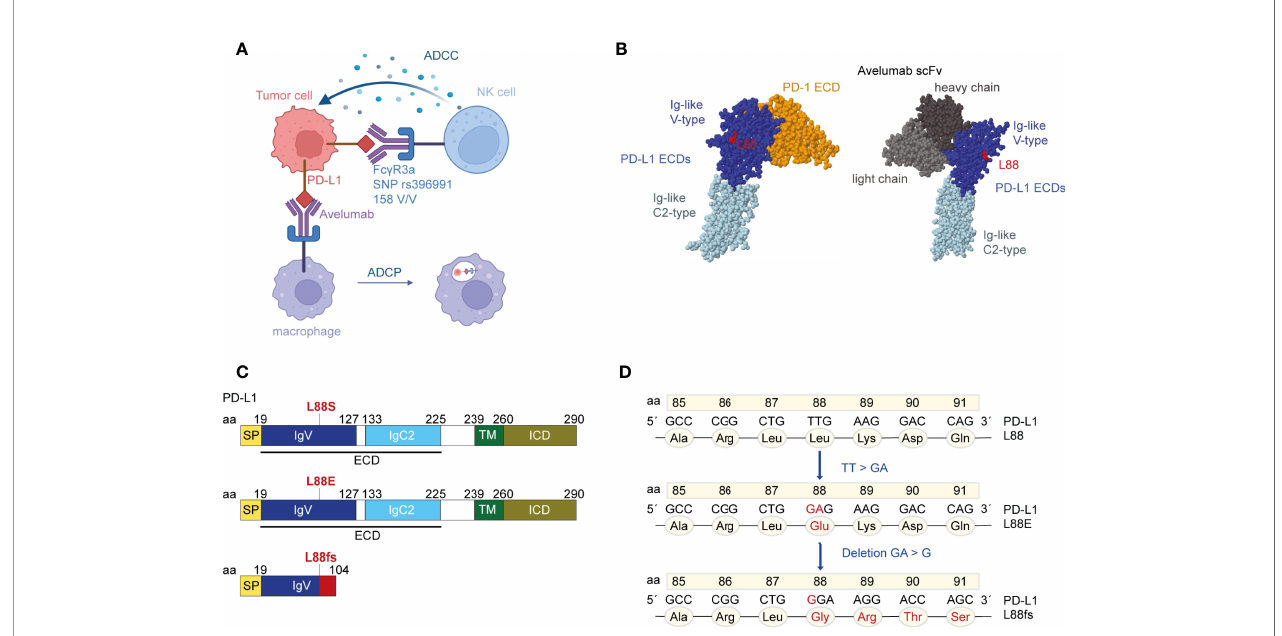
FIGURE 1 | The localization of residue leucine 88 in the extracellular domains (ECDs) of programmed cell death ligand 1 (PD-L1). (A) Binding of avelumab to PD-L1 promotes antibody-dependent cell-mediated cytotoxicity (ADCC) or antibody-dependent cell phagocytosis (ADCP) against tumor cells via the Fc g receptor. Patient 05-001 showed homozygosity for the FCGR3A SNP rs396991 (amino acid 158V/V, also known as 176V/V) that is known to mediate high-af fi nity binding of NK cells to IgG1 (12, 16). The fi gure was created with BioRender.com. (B) Crystal structure of PD-L1 ECDs in complex with PD-1 ECD [PDB ID: 3BIK (17)] and crystal structure of PD-L1 ECDs in complex with an avelumab single-chain variable fragment (scFv) [PDB ID: 5GRJ (18)]. Leucine 88 is highlighted in red. Space- fi lling models were created with RasMol (19). (C) Schematic structure of the human PD-L1 peptide with indications where the novel mutations theoretically introduce changes. PD-L1 L88fs leads to a premature termination codon and consecutively to loss of the transmembrane domain. (D) Nucleotide and amino acid exchanges found in patient 05-001 at week 9 and EOT in the PD-L1 L88